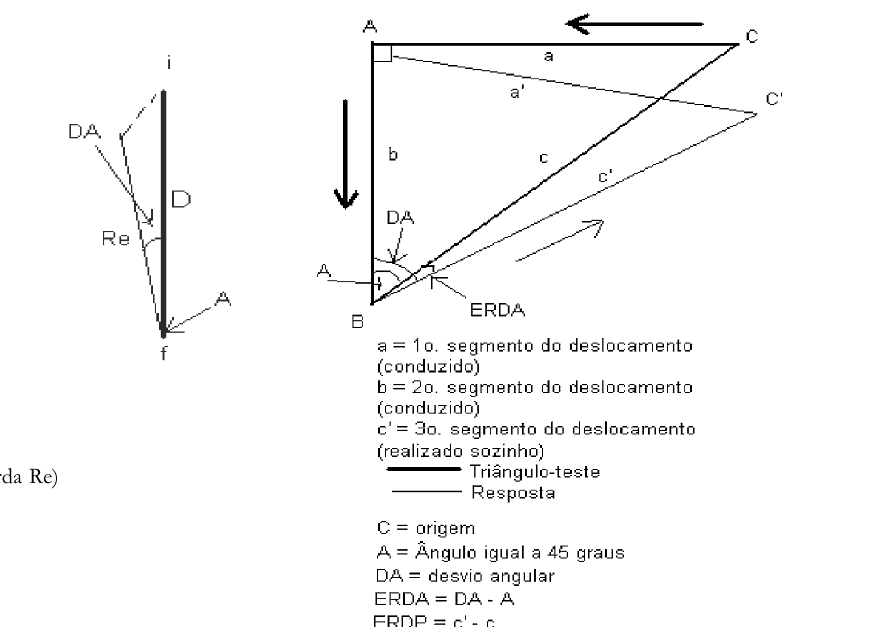
Figura 1. Esquema da tarefa em linha reta. Detalhes do procedimento de cÆlculo das variÆveis ERDA e ERDP. Figura 2. Esquema da tarefa tri(cid:226)ngulo. Detalhes do procedimento de cÆlculo das variÆveis ERDA e